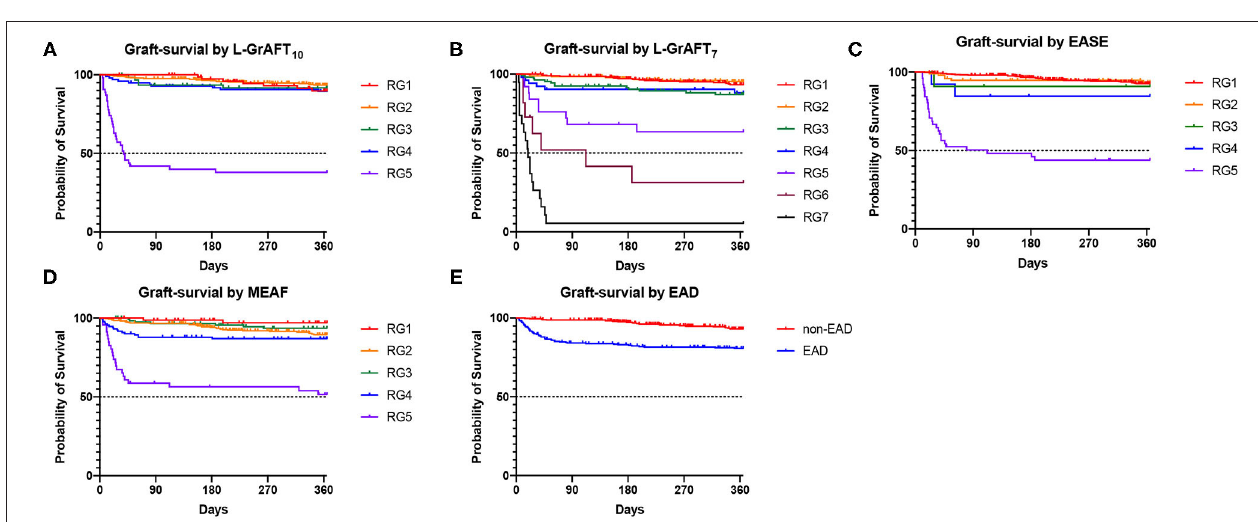
FIGURE 2 | Graft survival according to the L-GrAFT 10 , L-GrAFT 7 , EASE, MEAF, and EAD risk classes. (A) Graft-survival by L-GrAFT 10 ; (B) Graft-survival by L-GrAFT 7 ; (C) Graft-survival by EASE; (D) Graft-survival by MEAF; (E) Graft-survival by EAD. EAD, early allograft dysfunction; EASE, Early Allograft Failure Simplified Estimation; L-GrAFT, Liver Graft Assessment Following Transplantation; MEAF, Model for Early Allograft Function Scoring; RG, risk group.